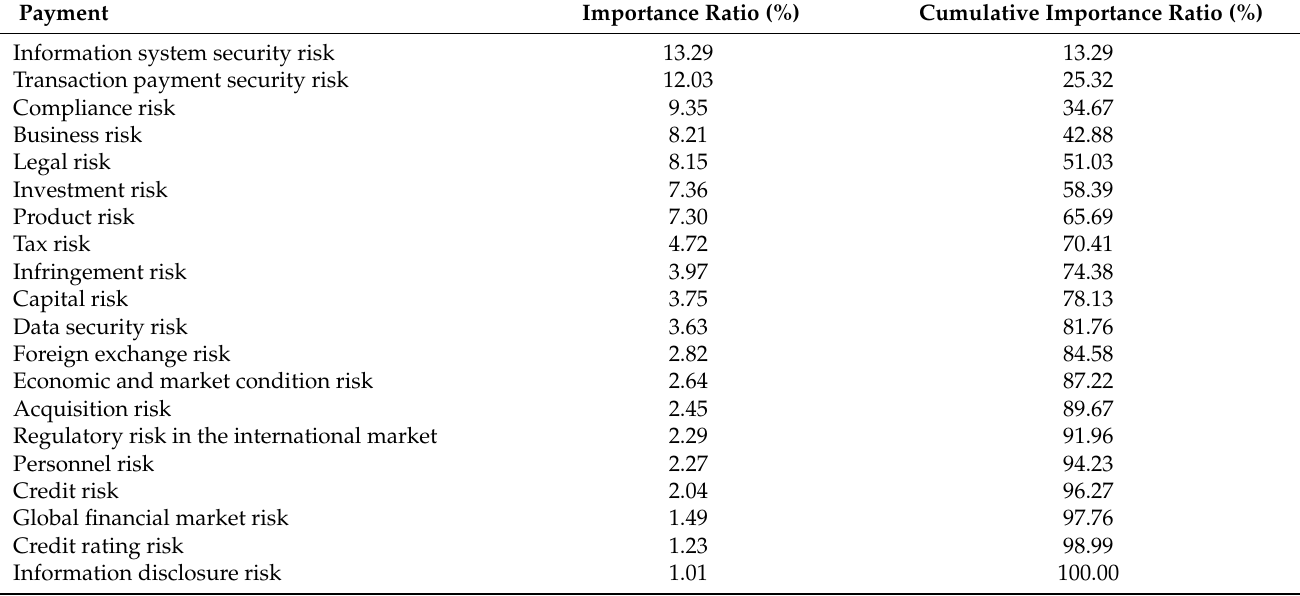
Table 5. The importance ratios of risks faced by the payment industry from 2015 to